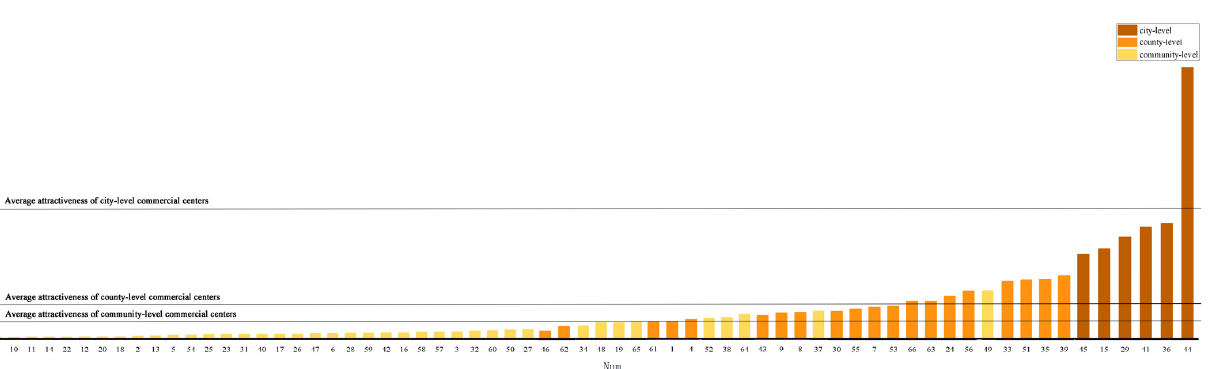
Figure 8. Gradients and intra-level differences in attractiveness of Wuhan’s commercial centers. Data sources: derived from LBS data (Table